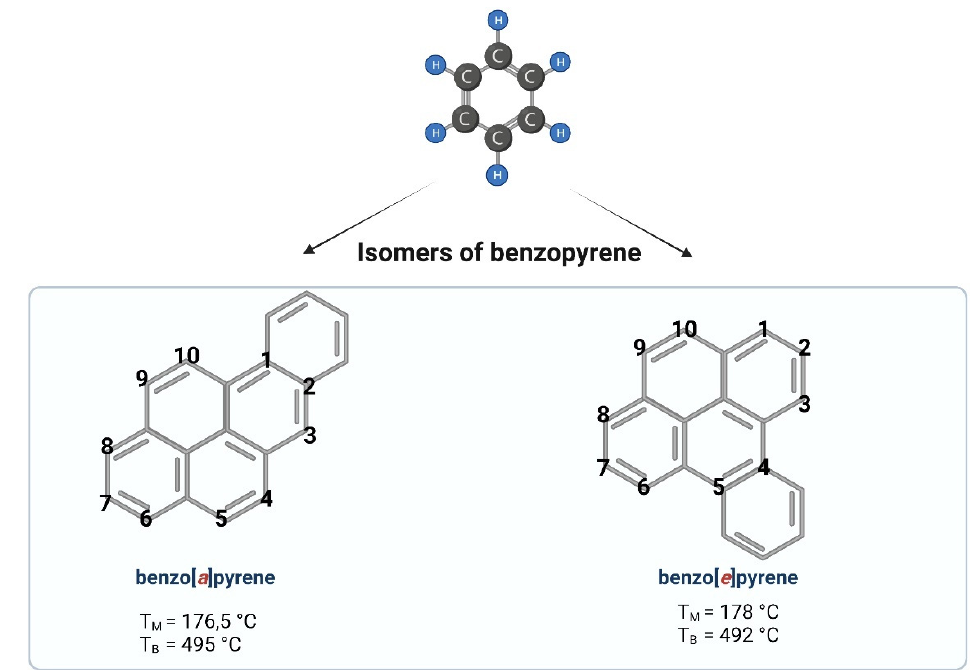
Figure 1. Chemical structures of benzopyrene. Created with BioRender.com (accessed on 12 April 2022).